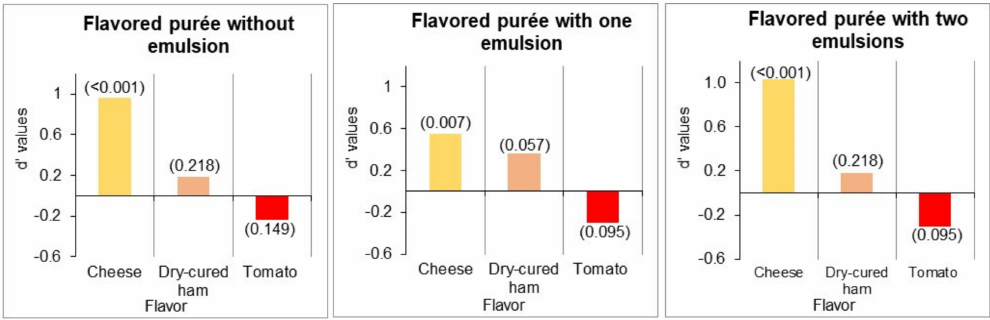
Figure 5. d’ values indicate the differences in the flavor intensity of the three pur é es with flavorings compared to the base pur é e. A positive value indicates a more intense flavor, and a negative value indicates a less intense flavor than in the base pur é e. The value on top of the bars corresponds to the probability indicating the significance of